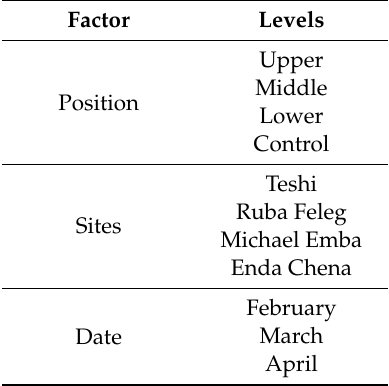
Table 2. Description of the factors and levels of the